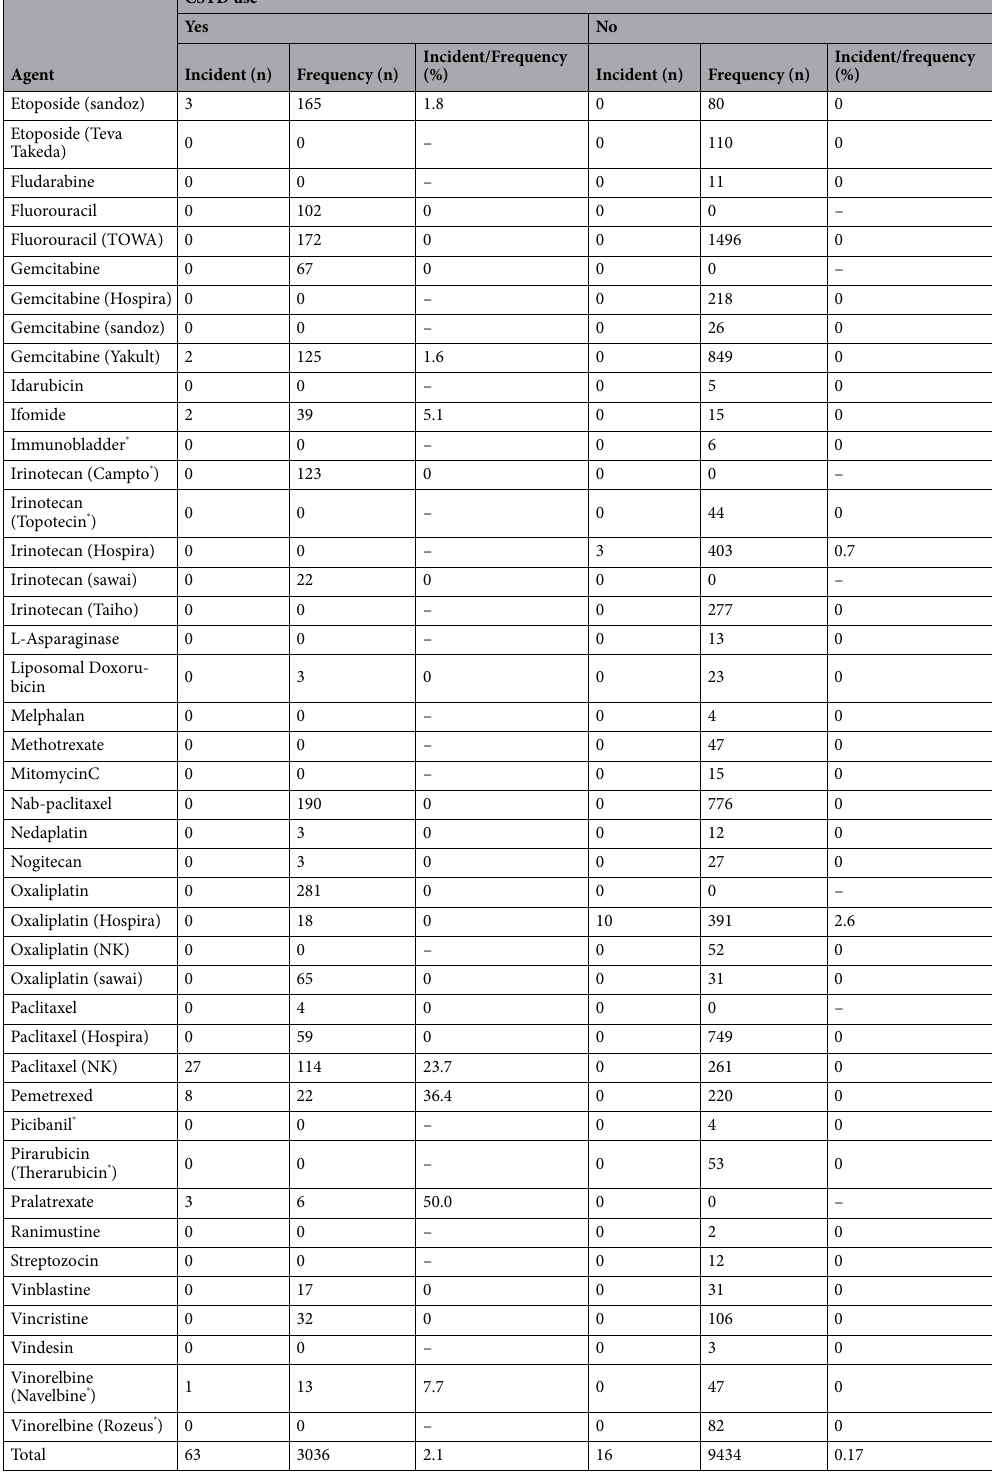
Table 3. Incidence and frequency of contaminations during preparation of anticancer agents at institutes in Ehime Prefecture providing chemotherapies with or without CSTD